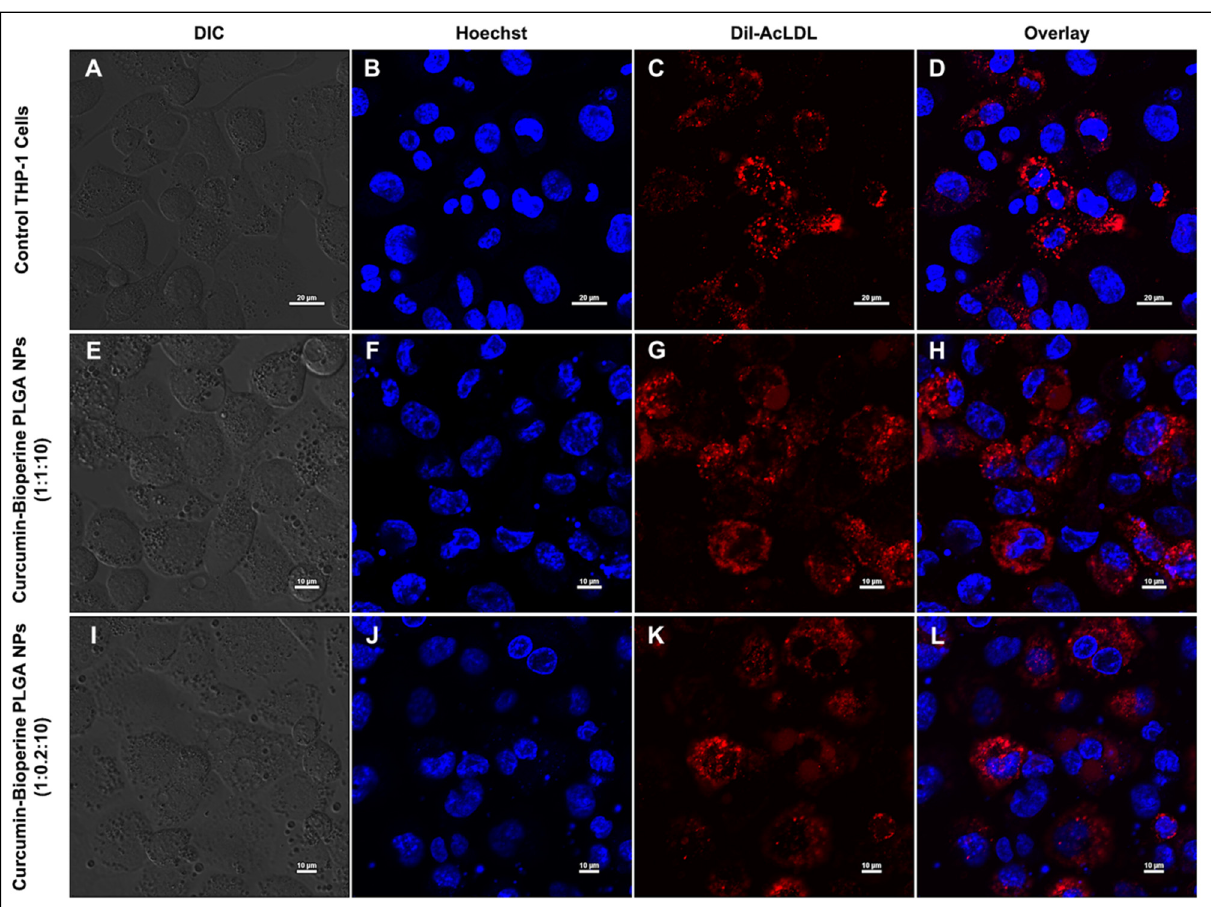
Figure 6. Confocal laser scanning microscopy analysis shows the Dil-AcLDL staining on THP-1 monocyte-derived macrophage cells to check the inhibition of foam cell formation. THP-1 monocyte-derived macrophage cells are pre-incubated with Dil-AcLDL for 4 h, followed by the treatment with both the ratios of curcumin-Bioperine PLGA NPs (1:1:10 and 1:0.2:10) for 24 h. The top panel ( A – D ) shows the control THP-1 monocyte-derived macrophage cells forming foam cells (scale bar 20 µ m). The second panel ( E – H ) shows the THP-1 monocyte-derived macrophage foam cells treated with curcumin-Bioperine PLGA NPs 1:1:10 (Scale bar 10 µ m). The third panel ( I – L ) shows the THP-1 monocyte-derived macrophage foam cells treated with curcumin-Bioperine PLGA NPs 1:0.2:10 (scale bar 10 µ